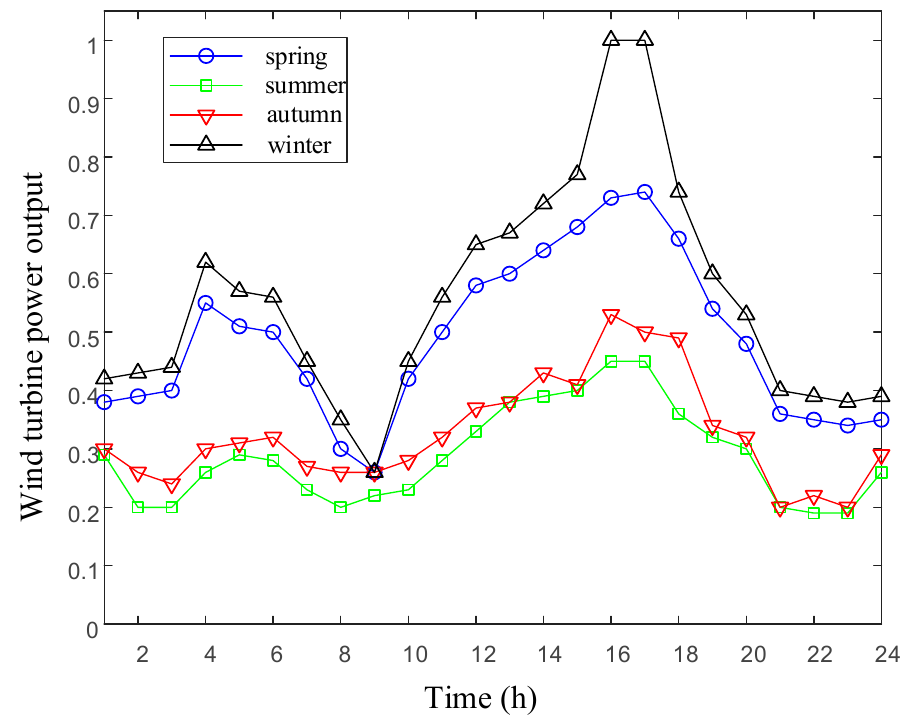
Figure 5. Output curve of wind turbine.